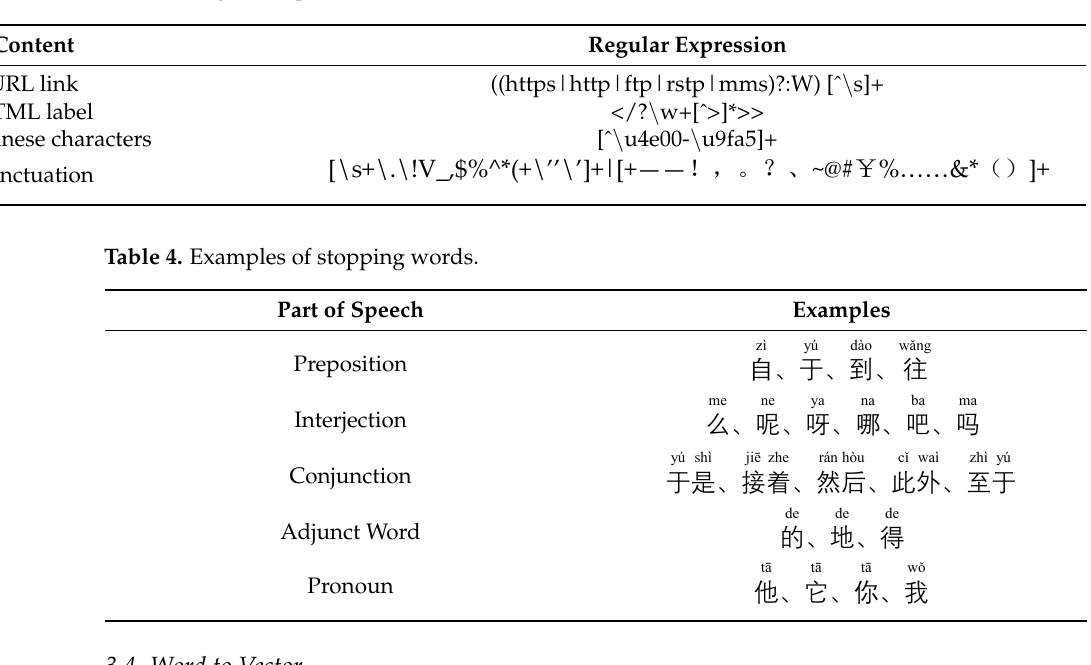
Table 3. Regular expressions for redundant information removal.